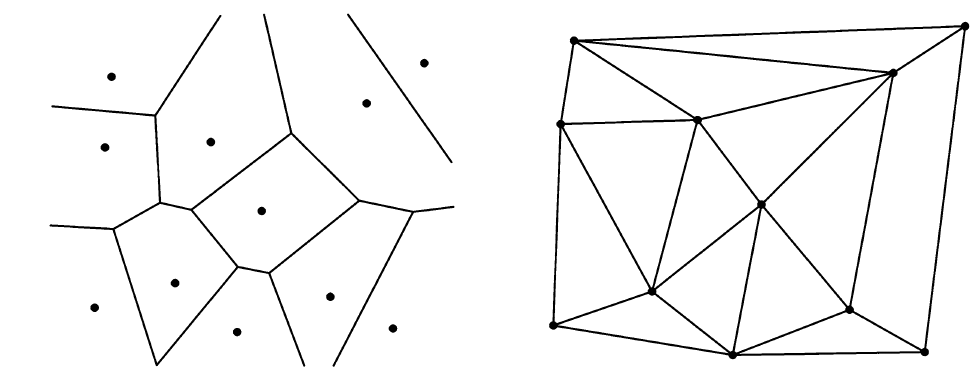
Fig. 4 Voronoi diagram (left) and Delaunay triangulation (right) of the same set of points (Remondino 2003a)